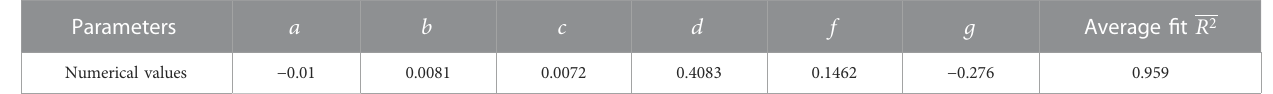
TABLE 9 Parameter fi tting values of Peng ’ s linear